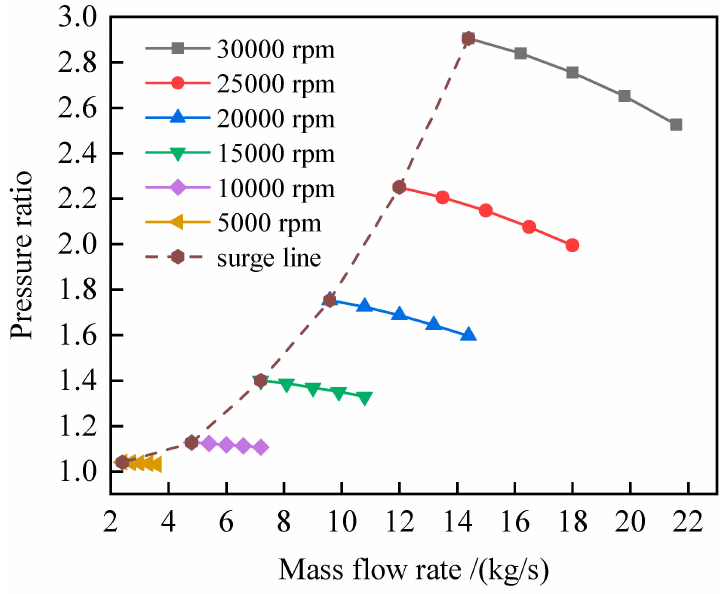
Figure 7. Compressor performance map (under the designed inlet